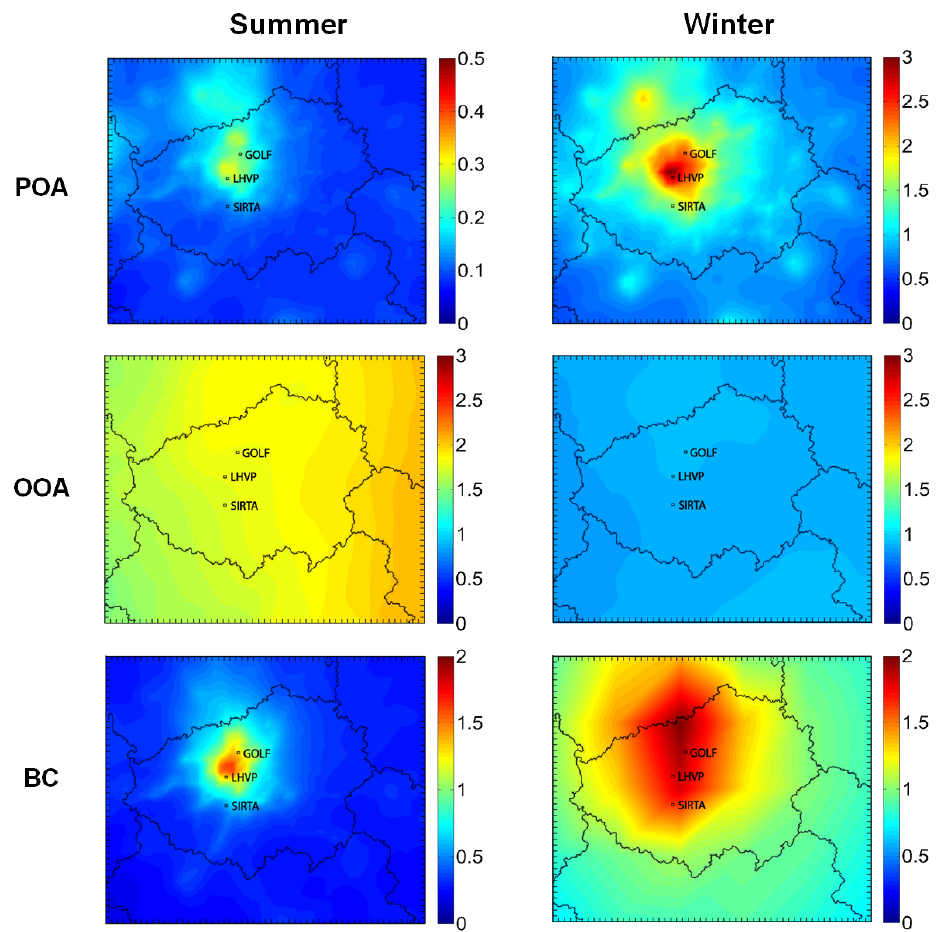
Figure 2. Predicted average ground concentrations (in µgm − 3 ) of fine fresh total POA, BC and OOA in the greater area of Paris during summer 2009 and winter 2010. Different scales are used.